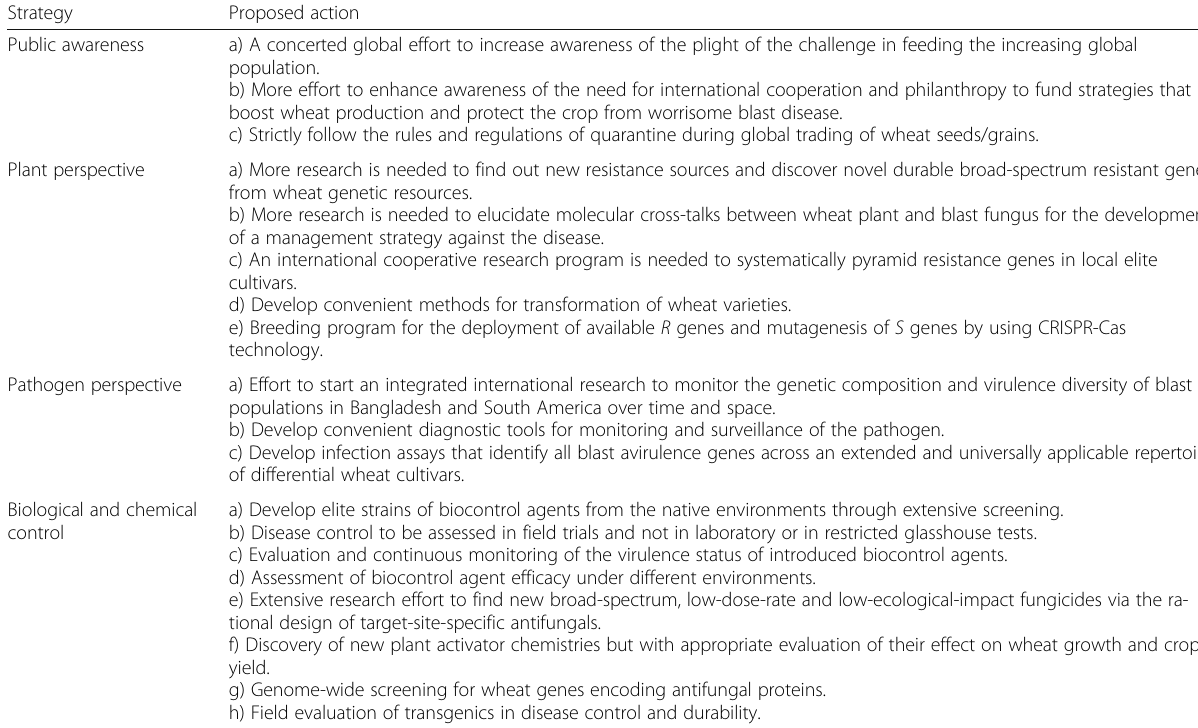
Table 4 Future directions towards the management of wheat blast disease